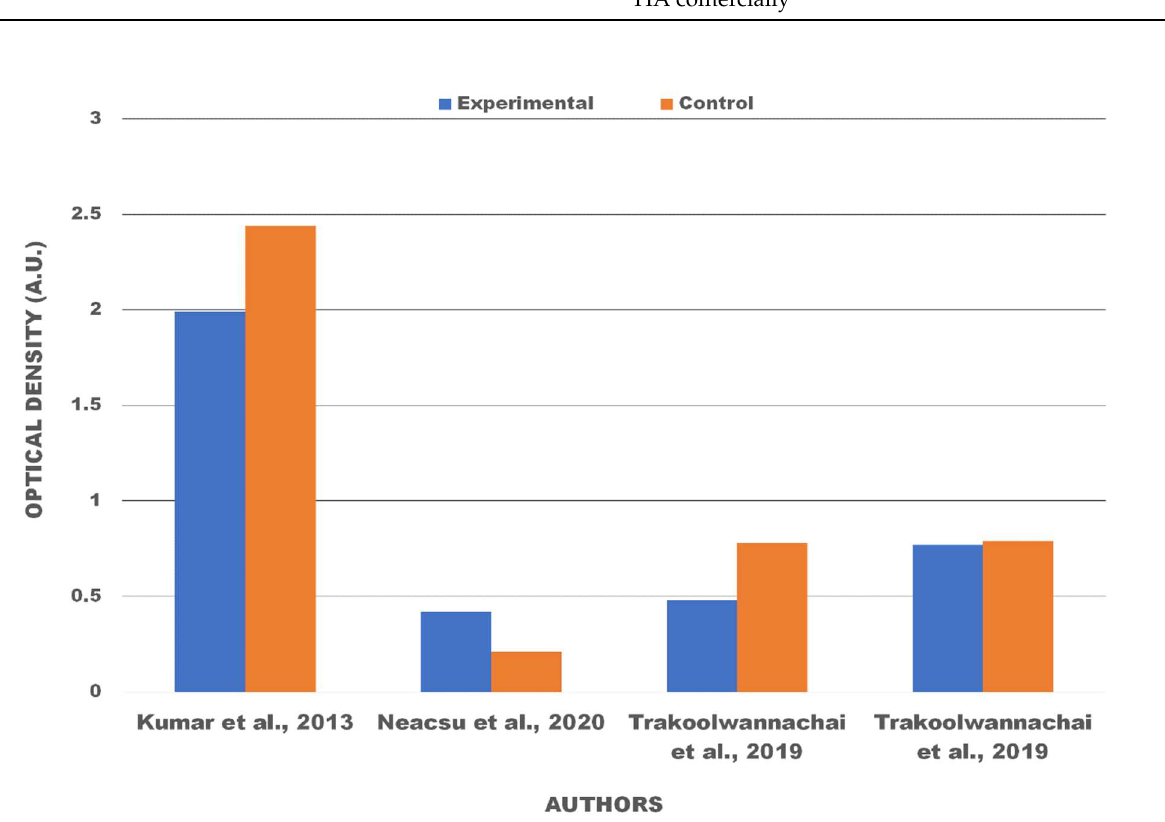
Figure 4. Optical density of materials after being cultured in various stem cells.